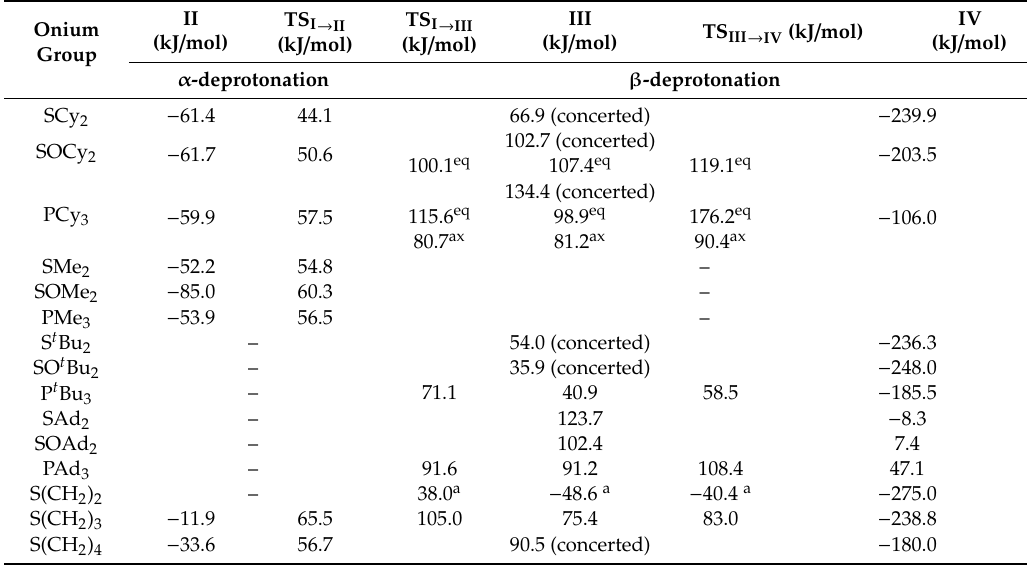
Table 2. Comparison of the proton shifts from the α - and β -position of the onium group to the carbene center. Energies are given relative to the corresponding CAYC I (PBE0-def2svp / PBE0-def2tzvp; PCM with THF as